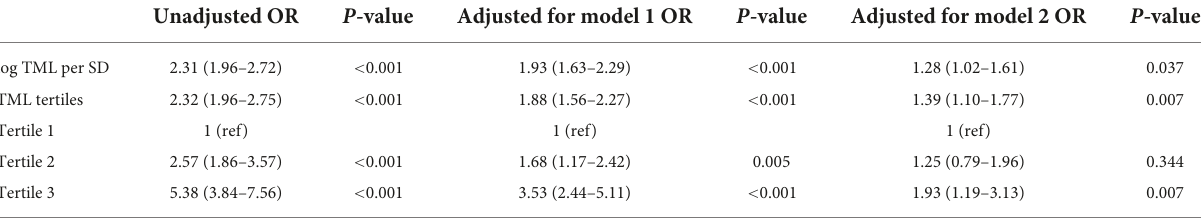
TABLE 2 Trimethyllysine (TML) was associated with the presence of heart failure (HF) in all subjects. Unadjusted